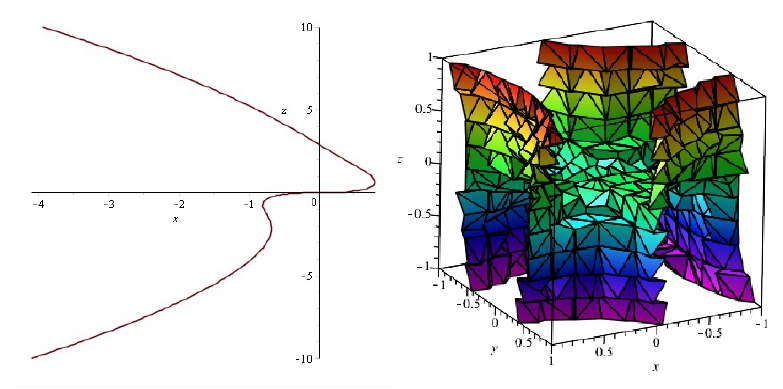
Figure 2. left : algebraic curve γ 2 ( u ) ; right : algebraic surface E 2 ( x , y , z ) =